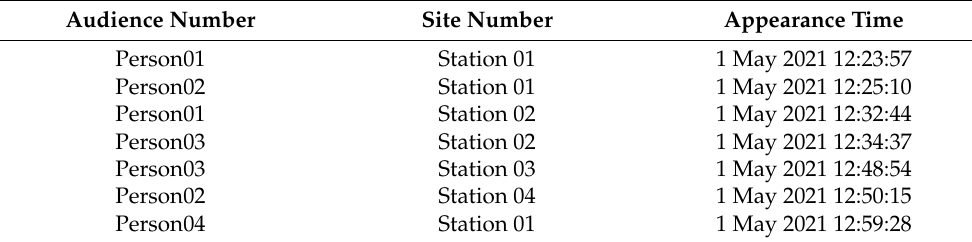
Table 3. Audience geographic information provided by the base